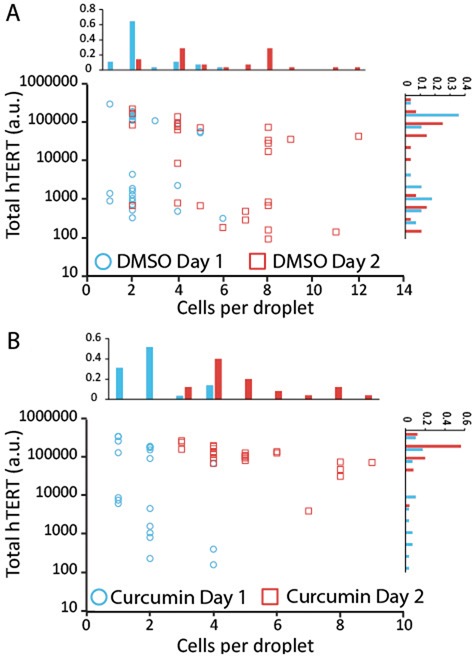
(A) Scatter plot of total hTERT transcript abundance versus cells per droplet for DMSO-treated control K562 cell cultures and associated normalized histograms of cells per droplets (top plot) and transcript abundance (right plot). Significant bimodal total hTERT transcript abundance can be seen for both day 1 and 2 (Day 1: dip = 0.136, P < 0.0001; Day 2: dip = 0.111, P = 0.0054). (B) Scatter plot of total hTERT transcript abundance versus cells per droplet for 1 μM curcumin-treated K562 cell cultures and associated normalized histograms of cells per droplets (top plot) and expression levels (right plot). A decrease in hTERT transcript abundance bimodality occurs on day 2 (Day 1: dip = 0.0995, P = 0.083; Day 2: dip = 0.0419, P = 0.993).